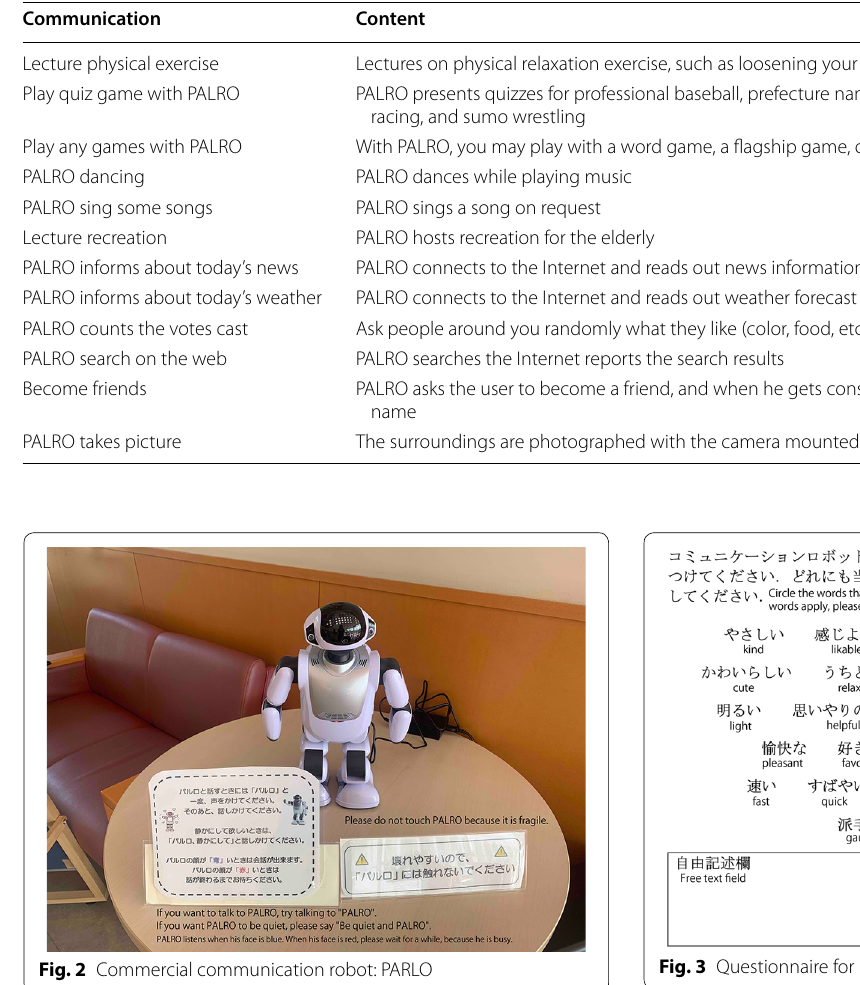
Table 1 PALRO’s communication function list